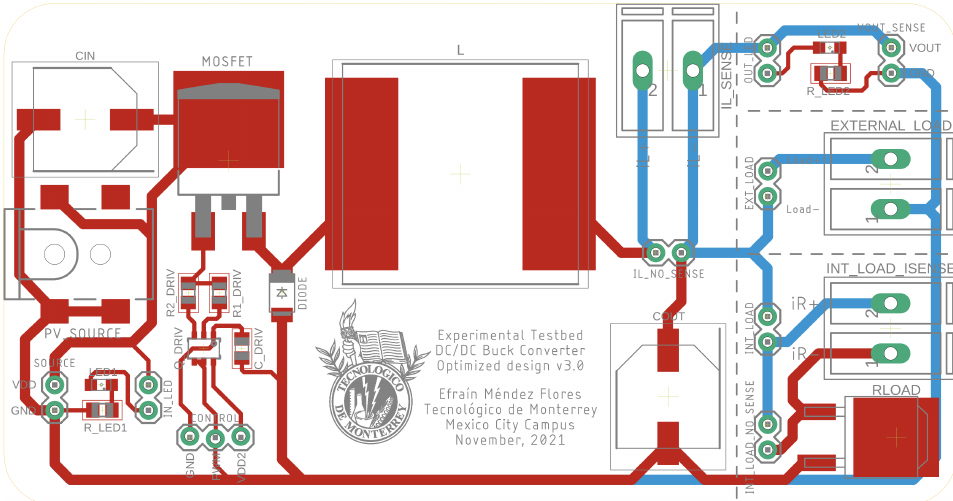
Figure 24. PCB layout design regarding the DC–DC converter optimally designed for the PV application.